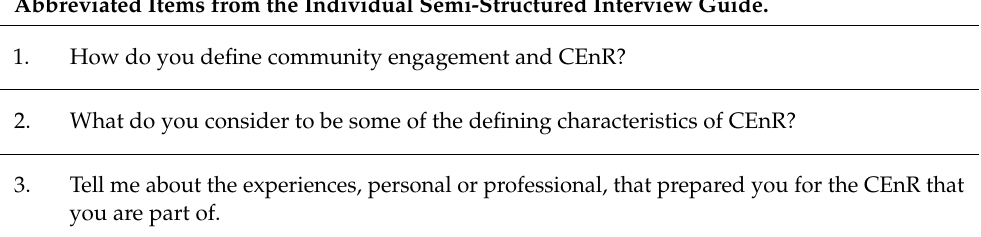
Table 1. Abbreviated items from the individual semi-structured interview